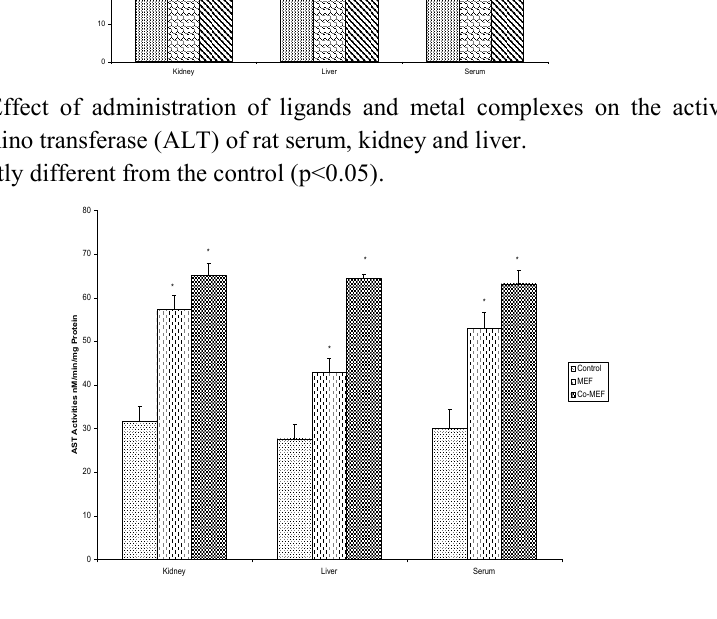
Figure 5. Effect of administration of ligands and metal complexes on the activities of alkaline phosphatase (AST) of rat serum, kidney and liver. * Significantly different from the control